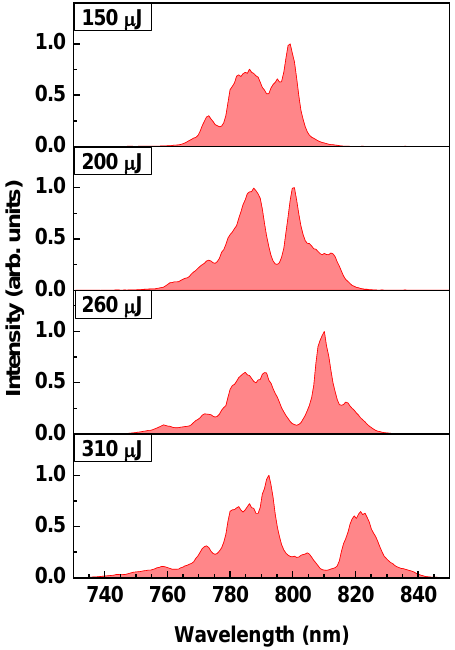
Figure 4. Spectra of the output pump pulses from the air-filled hollow fiber at pump